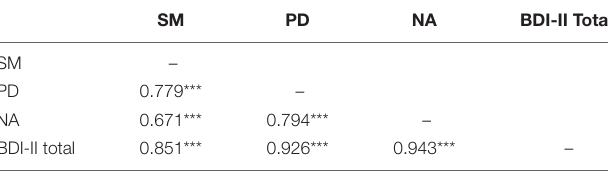
TABLE 4 | Correlation coefficients of the BDI-II total score with BDI-II sub-factors.